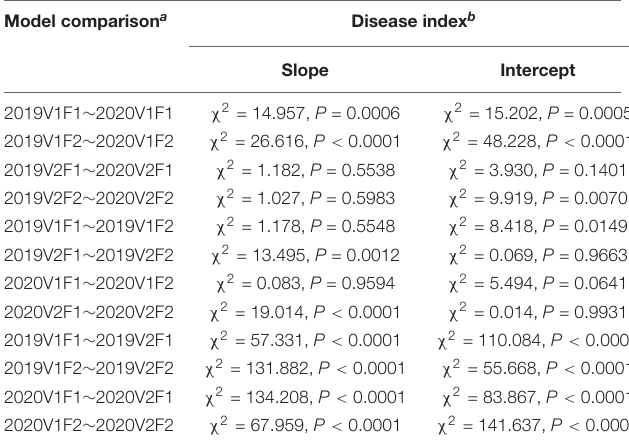
TABLE 8 | Comparative analyses of the relationship models between disease indexes and active ingredient dosages of two fungicides on different resistant